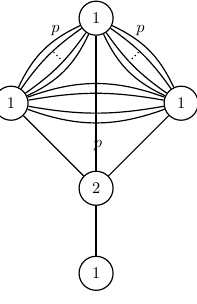
Figure 31 . 3d mirrors from class S construction for ( A s , D generic p . The gauge group is obtained by factoring out an overall U(1) , which can be implemented by ungauging any one of the U(1) gauge nodes.